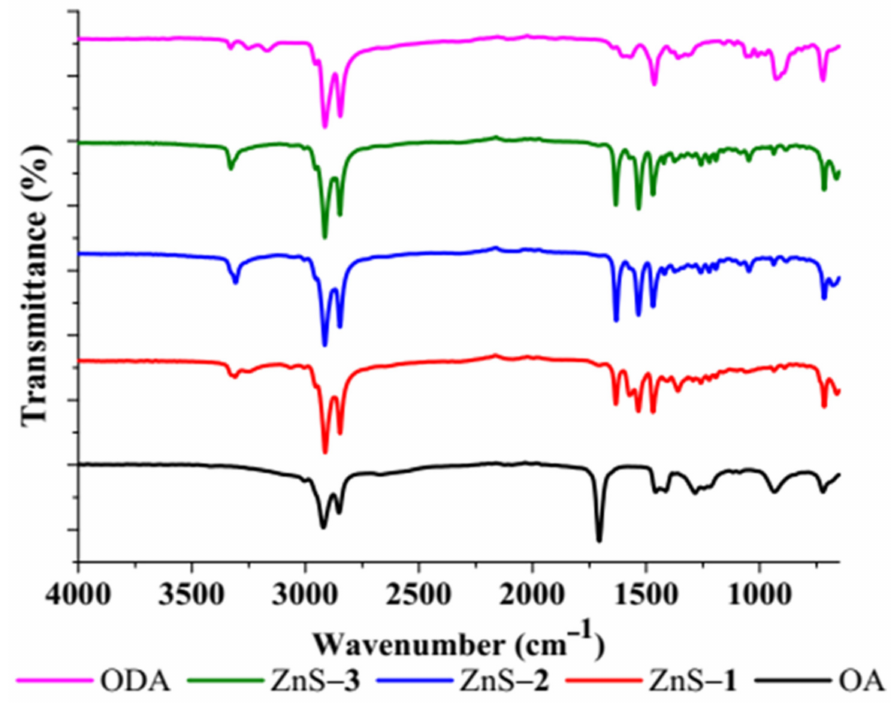
Figure 2. FTIR spectra of ZnS quantum